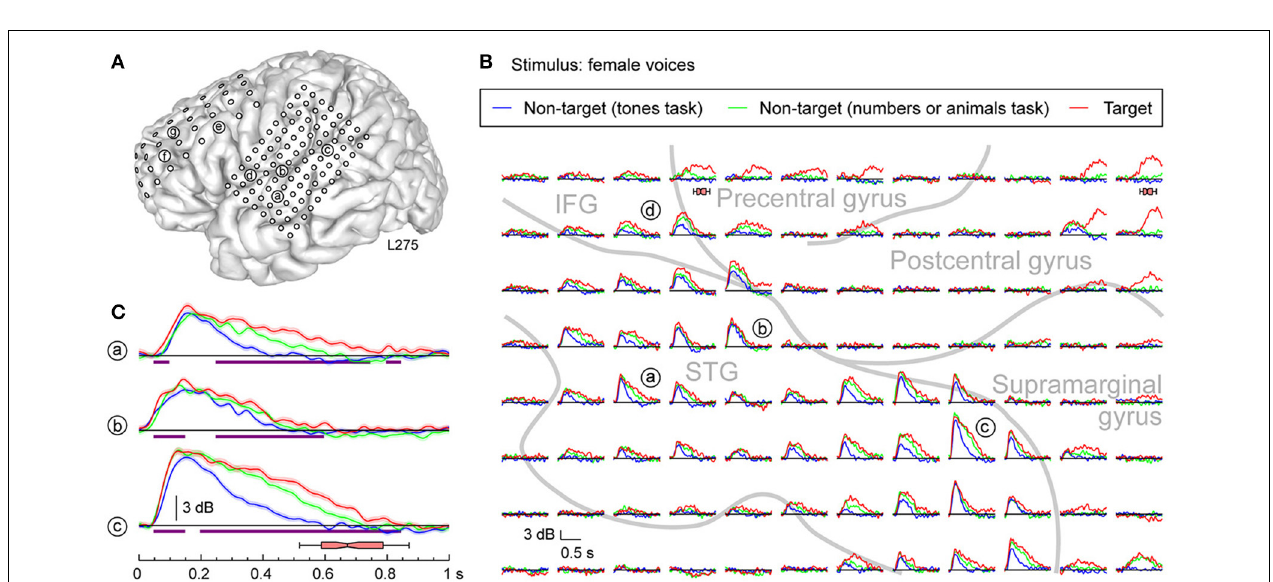
represent mean high gamma ERBP and its standard error, respectively. Purple bars denote time windows where responses to the target stimuli were significantly larger than those to the same stimuli in the tones task ( q < 0 . 01). Horizontal box plots denote the timing of behavioral responses to the target stimuli (medians, 10th, 25th, 75th, and 90th percentiles).